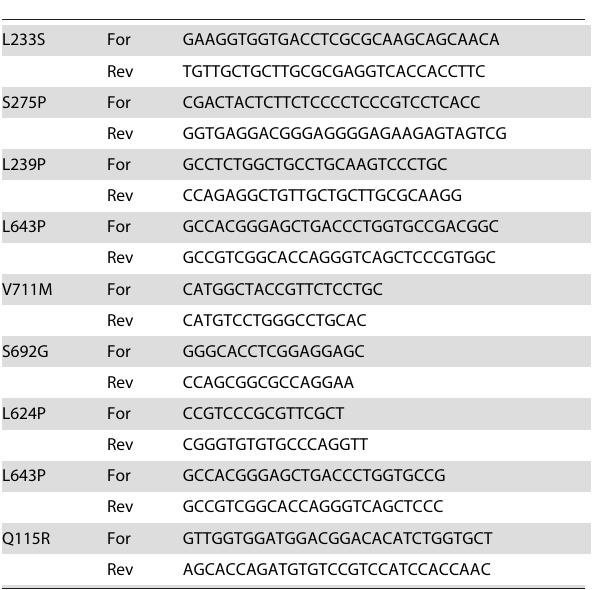
Table 4. Primers for site directed mutagenesis of GGAP2.